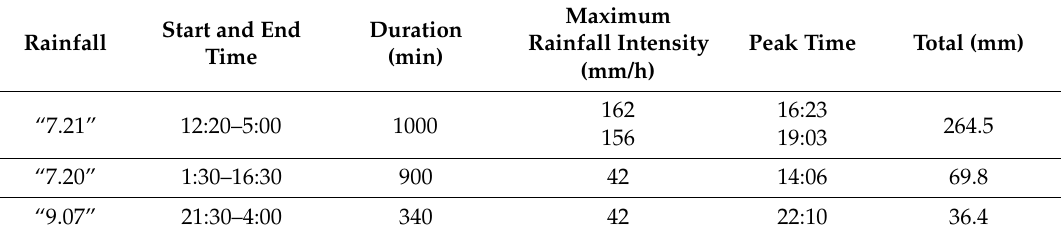
Table 1. Characteristics of the three chosen rainfall